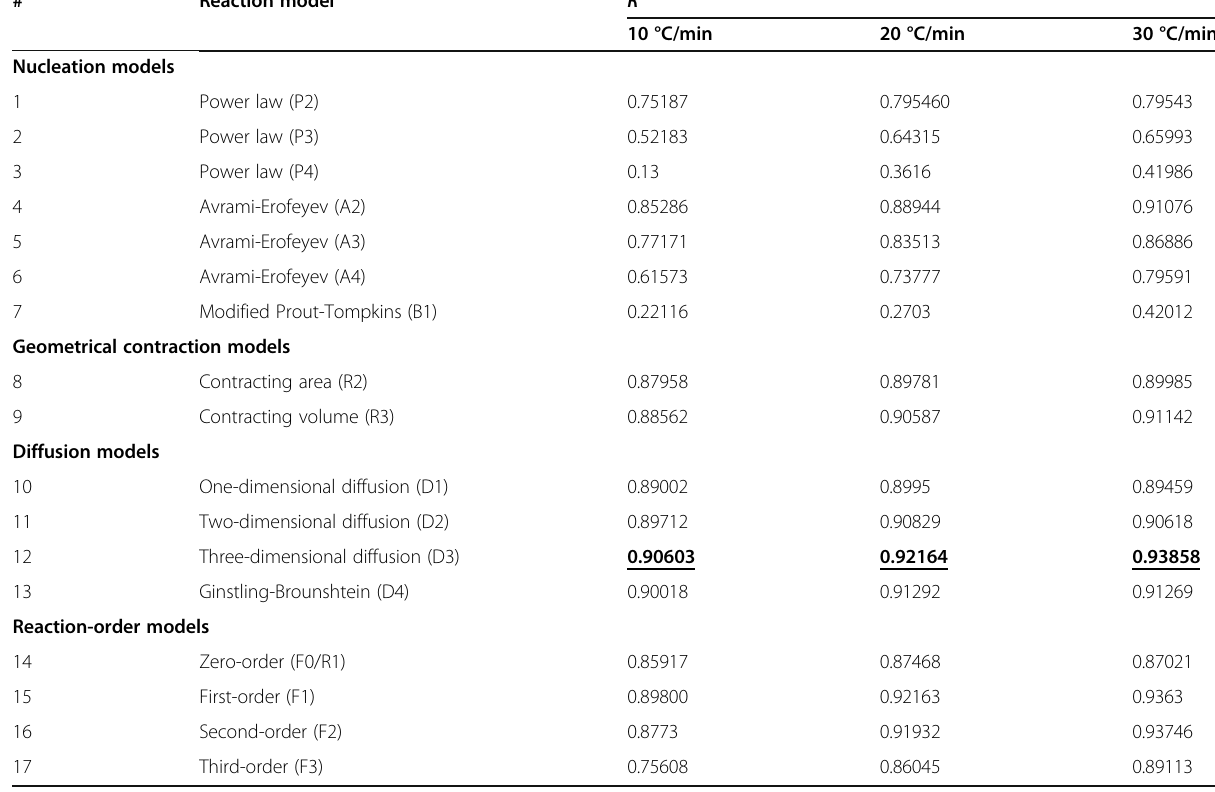
Table 2 Solid-state curve fitting parameter ( R 2 ) by CR method for TGA experiments at different heating rates